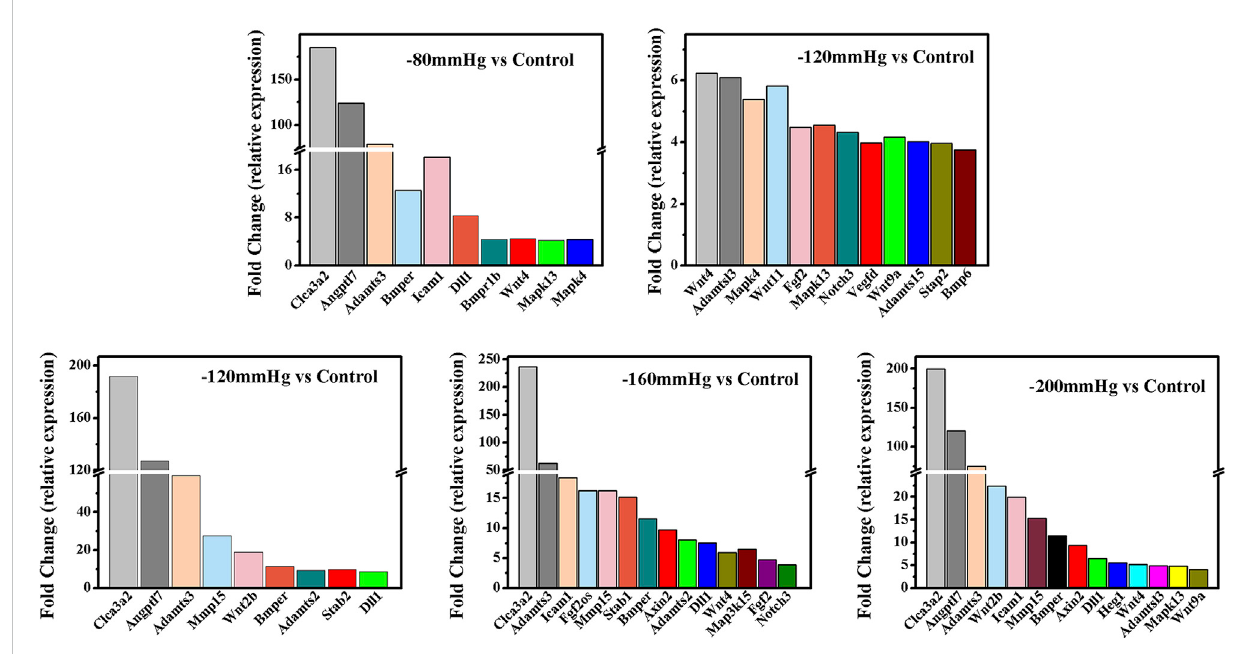
FIGURE 10 The osteogenesis associated DEGs in − 80 mmHg vs. control, − 120 mmHg vs. control, − 160 mmHg vs. control, and − 200 mmHg vs. control.